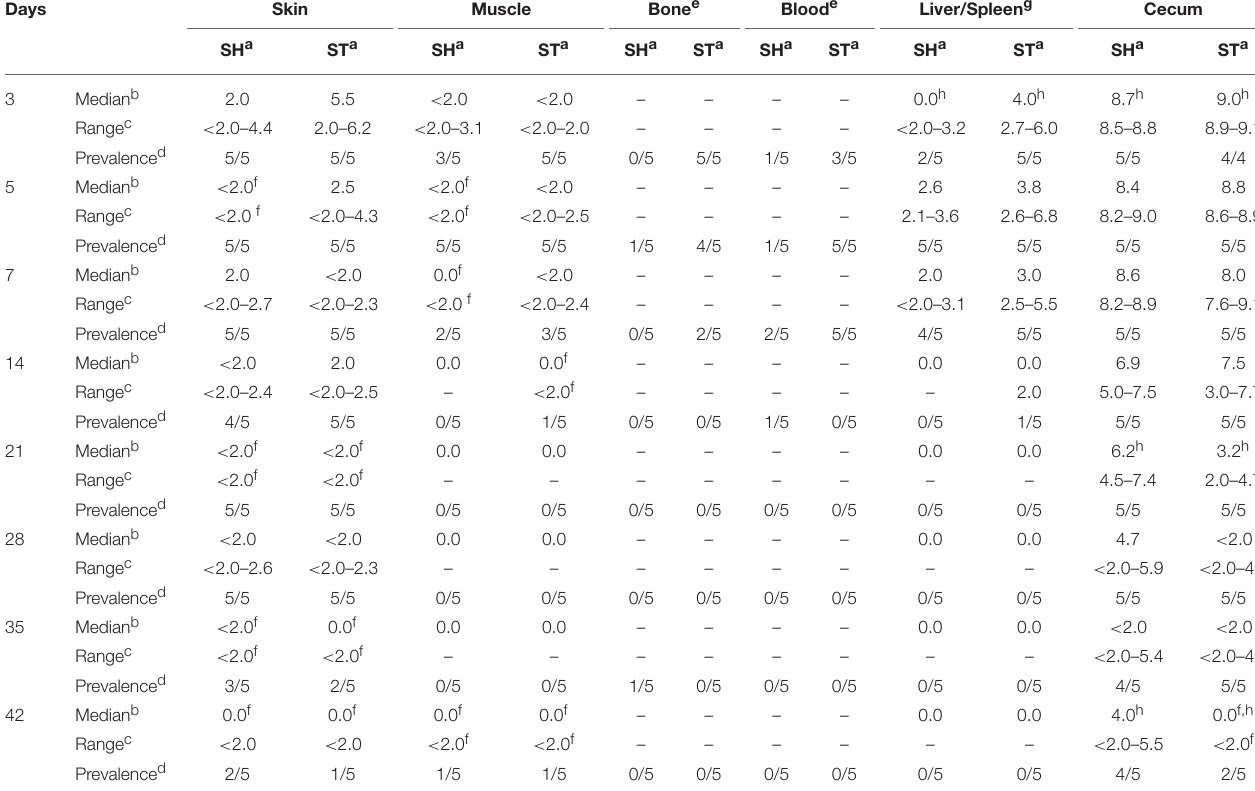
TABLE 1 | Salmonella prevalence and abundance in chickens infected with S . Heidelberg or S .